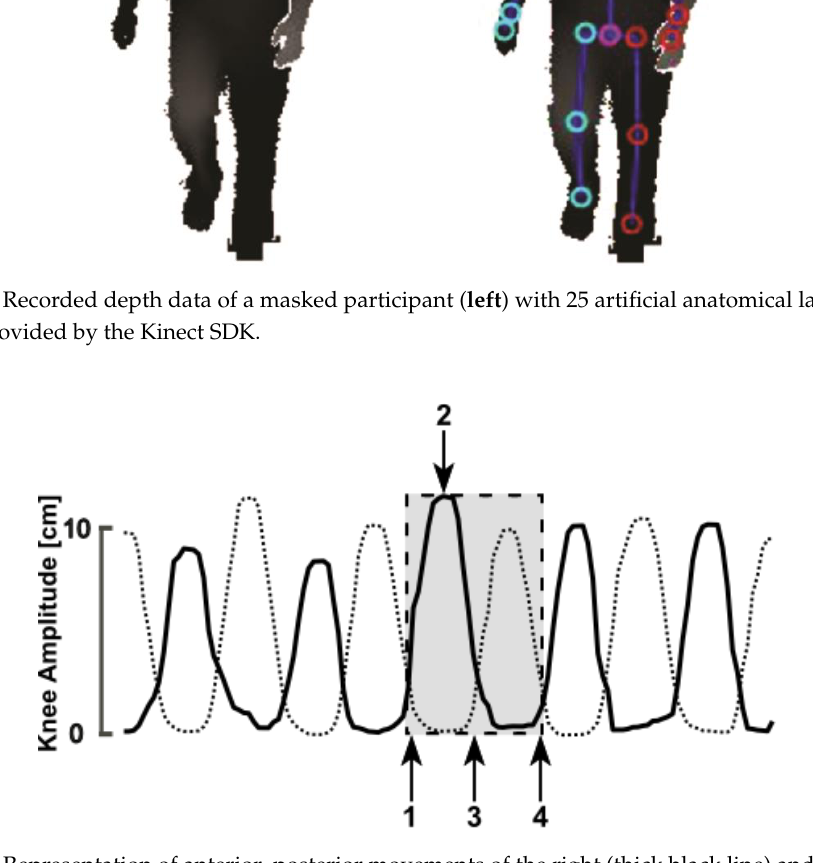
Figure 3. Representation of anterior–posterior movements of the right (thick black line) and left (thin dotted line) knee. The dashed box shows a complete stepping cycle including one step of each side. The following two phases are differentiated: Step phase of the right leg (from point 1 to 3) and stance phase (from point 3 to 4). Point 2 indicates the moment of anterior knee excursion (maximum hip flexion) and is used for the calculation of the knee amplitudes.